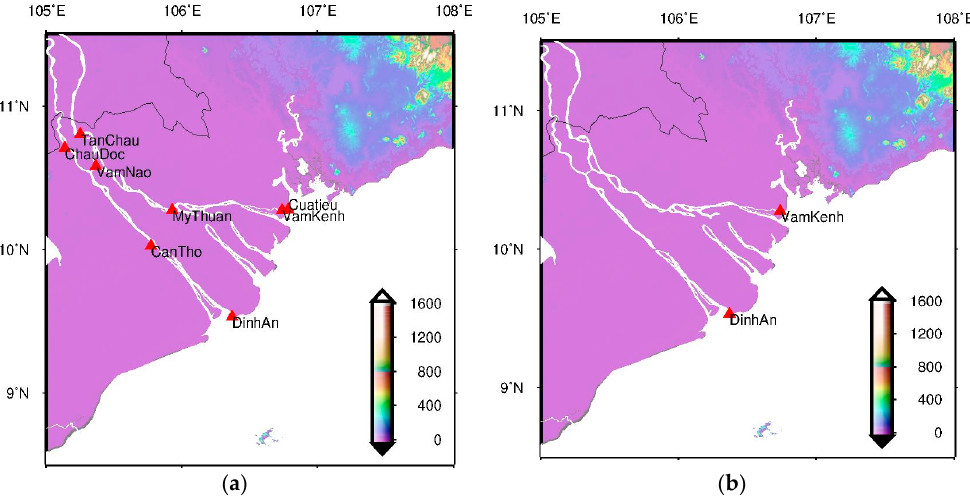
Figure 1. Map of the lower Mekong River Basin ( a ) with all stations in red triangles (that have discharge and water level measurements) and ( b ) selected stations (with water level measurements) the river mouth in this study due to longer data time situated near the river mouth in this study due to longer data time series.